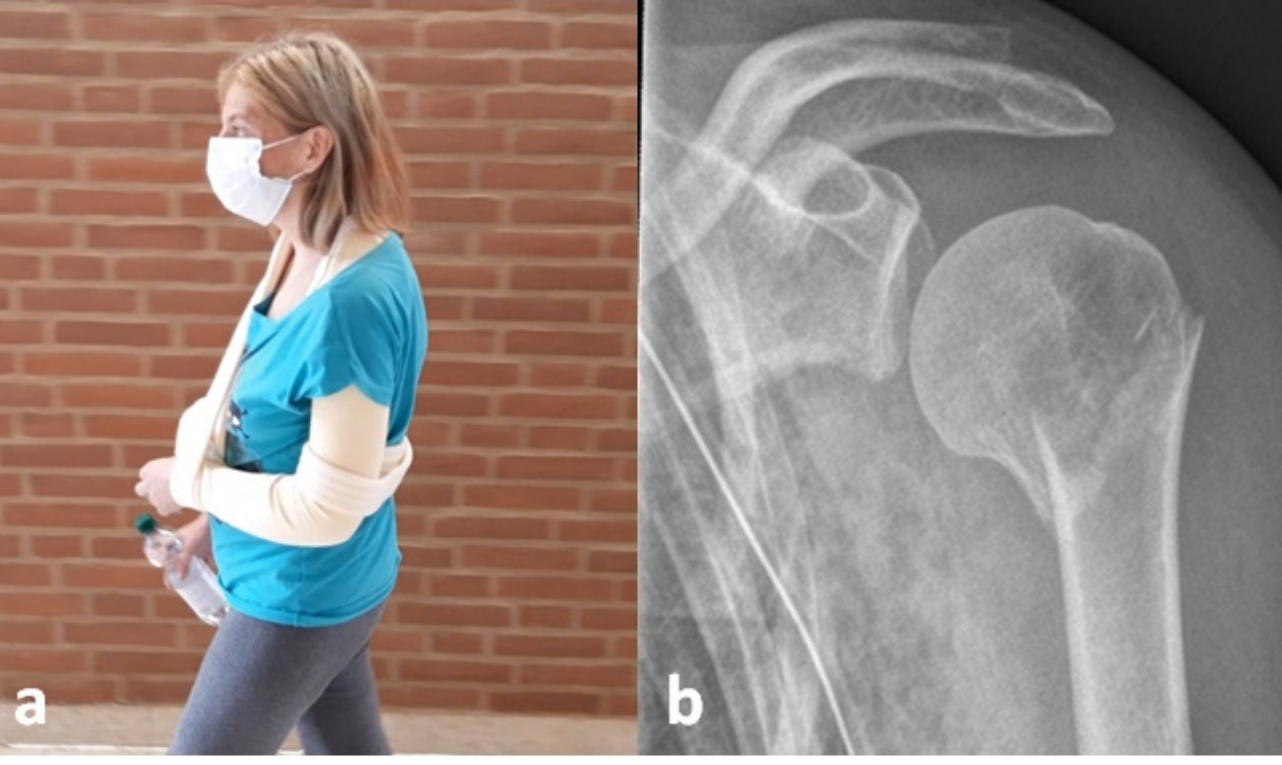
Table 1. Details about age, gender, reasons for immobility, and fracture type of each patient. Patientno.